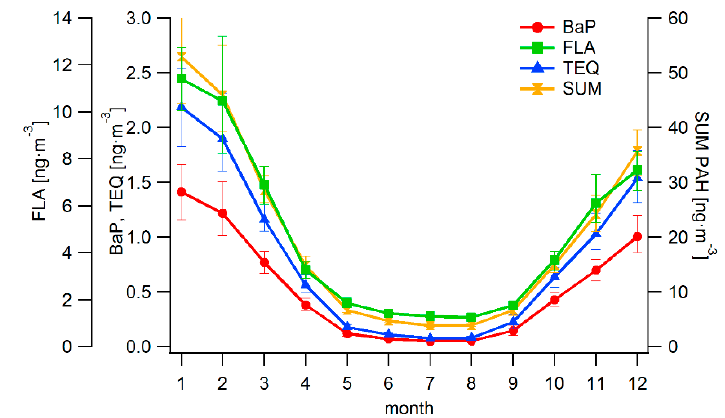
Figure 4. Average monthly concentrations (in ng · m − 3 ) of 4 selected PAH representatives—BaP, TEQ, FLA, and PAH SUM (curve values) together with 95% confidence intervals for the mean (whiskers).